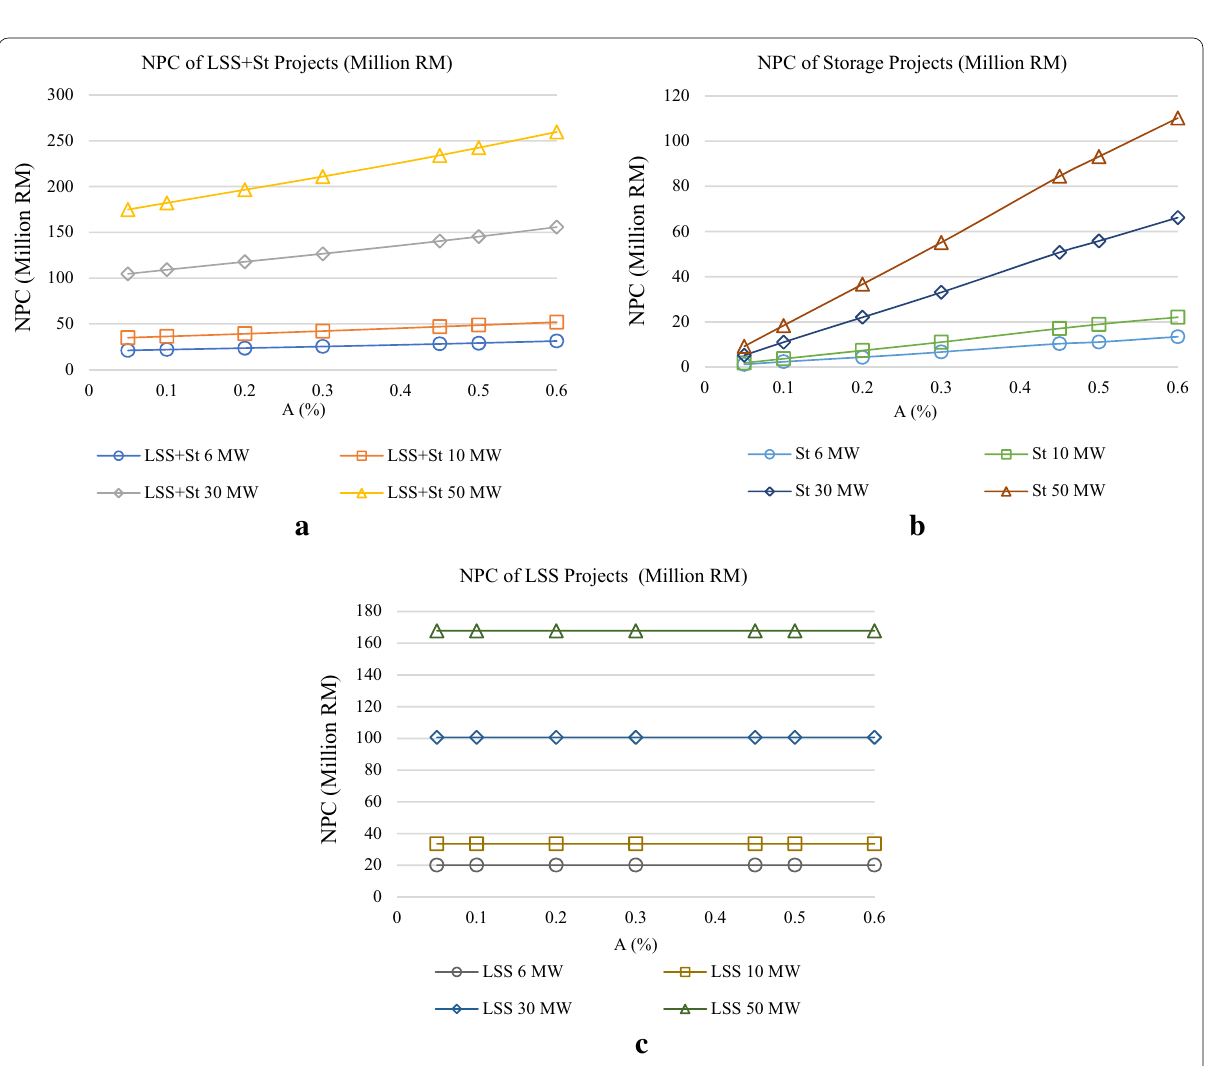
Fig. 5 Net present cost of different LSS capacities with variation of A . a LSS with storage projects, b storage projects, c LSS